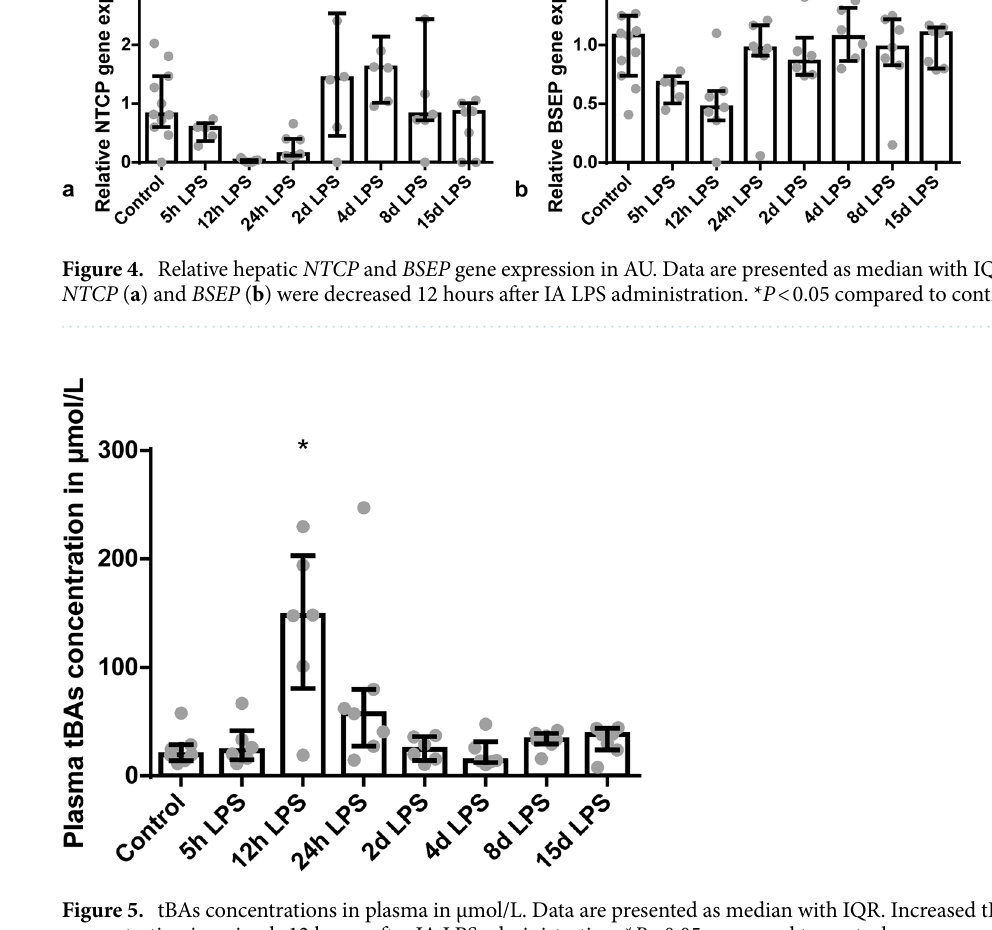
Figure 5. tBAs concentrations in plasma in μmol/L. Data are presented as median with IQR. Increased tBAs concentration in animals 12 hours after IA LPS administration. * P < 0.05 compared to